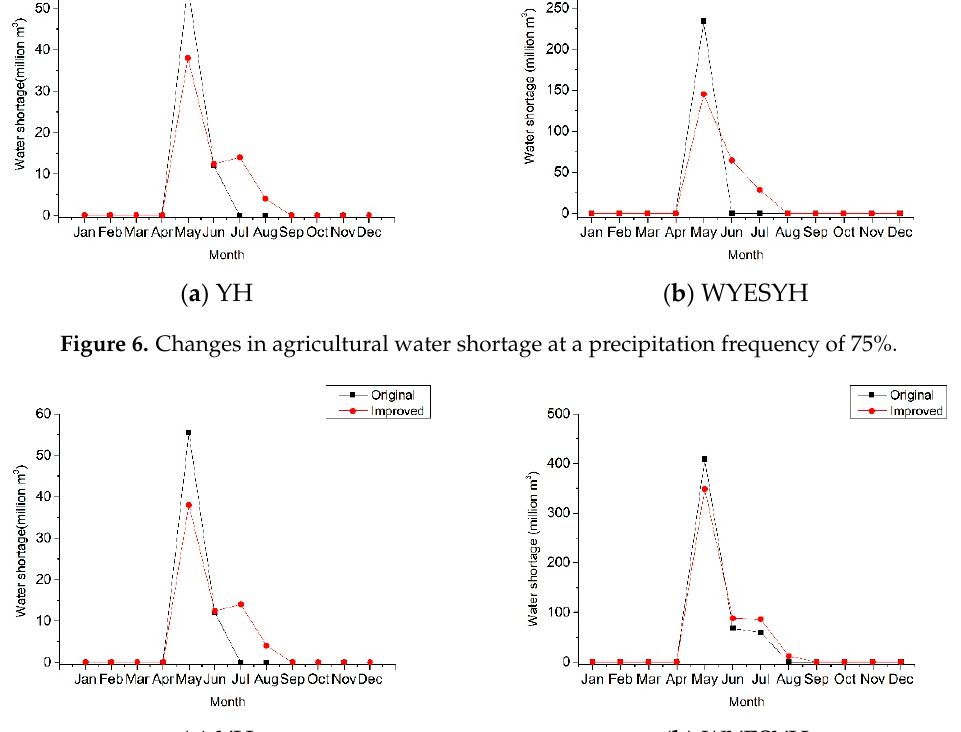
Figure 7. Changes in agricultural water shortage at a precipitation frequency of 90%.